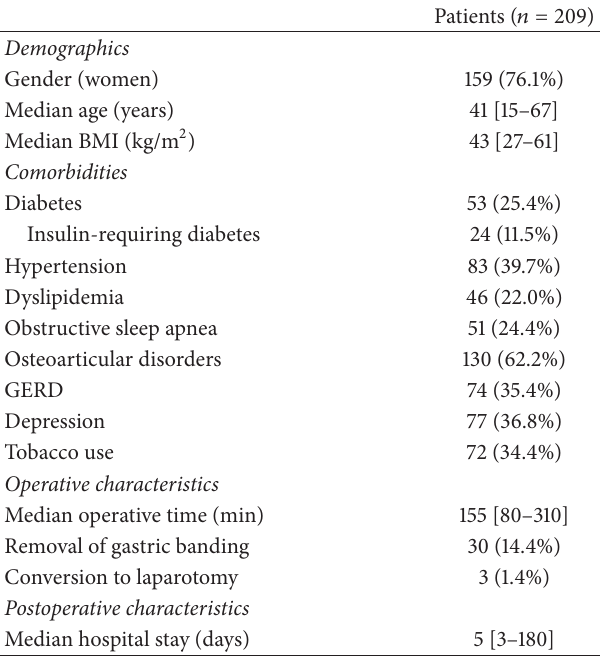
Table 1: Demographics, comorbidities, and operative and postop- erative characteristics.